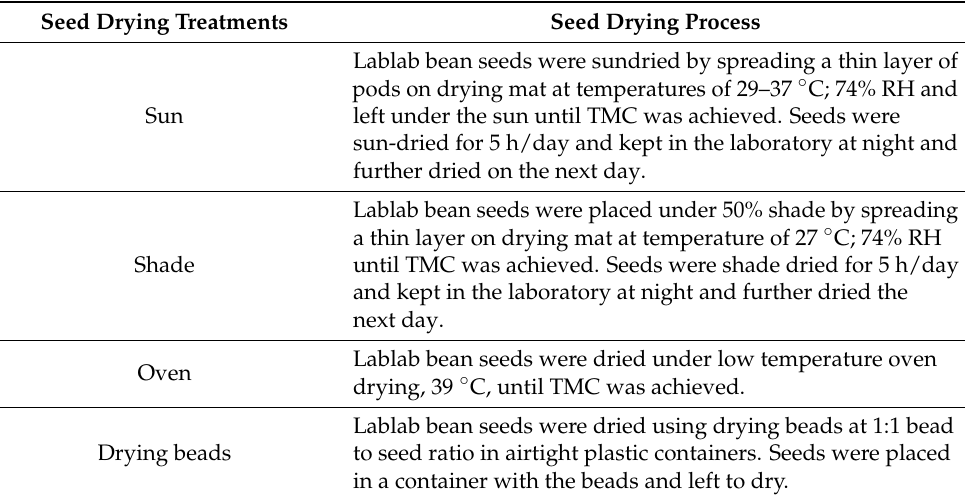
Table 1. Seed drying treatments and processes for lablab bean seeds used in this study. Seed Drying Treatments Seed Drying Process Lablab bean seeds were sundried by spreading a thin layer of pods on drying mat at temperatures of 29–37 ◦ C; 74% RH and Sun left under the sun until TMC was achieved. Seeds were sun-dried for 5 h/day and kept in the laboratory at night and further dried on the next day. Lablab bean seeds were placed under 50% shade by spreading a thin layer on drying mat at temperature of 27 ◦ C; 74% RH Shade until TMC was achieved. Seeds were shade dried for 5 h/day and kept in the laboratory at night and further dried the next day. Lablab bean seeds were dried under low temperature oven Oven drying, 39 ◦ C, until TMC was achieved. Lablab bean seeds were dried using drying beads at 1:1 bead Drying beads to seed ratio in airtight plastic containers. Seeds were placed in a container with the beads and left to